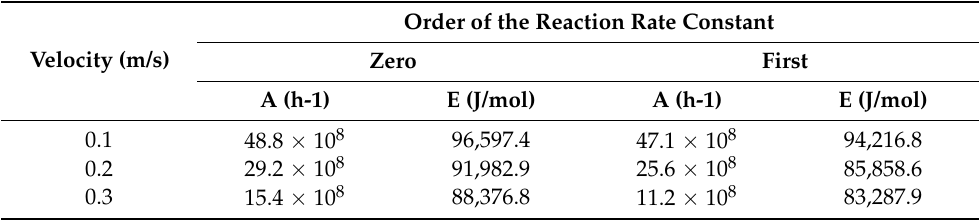
Table 3. The activation energy and frequency factor values of the expressed rate constant. Order of the Reaction Rate Velocity (m/s)